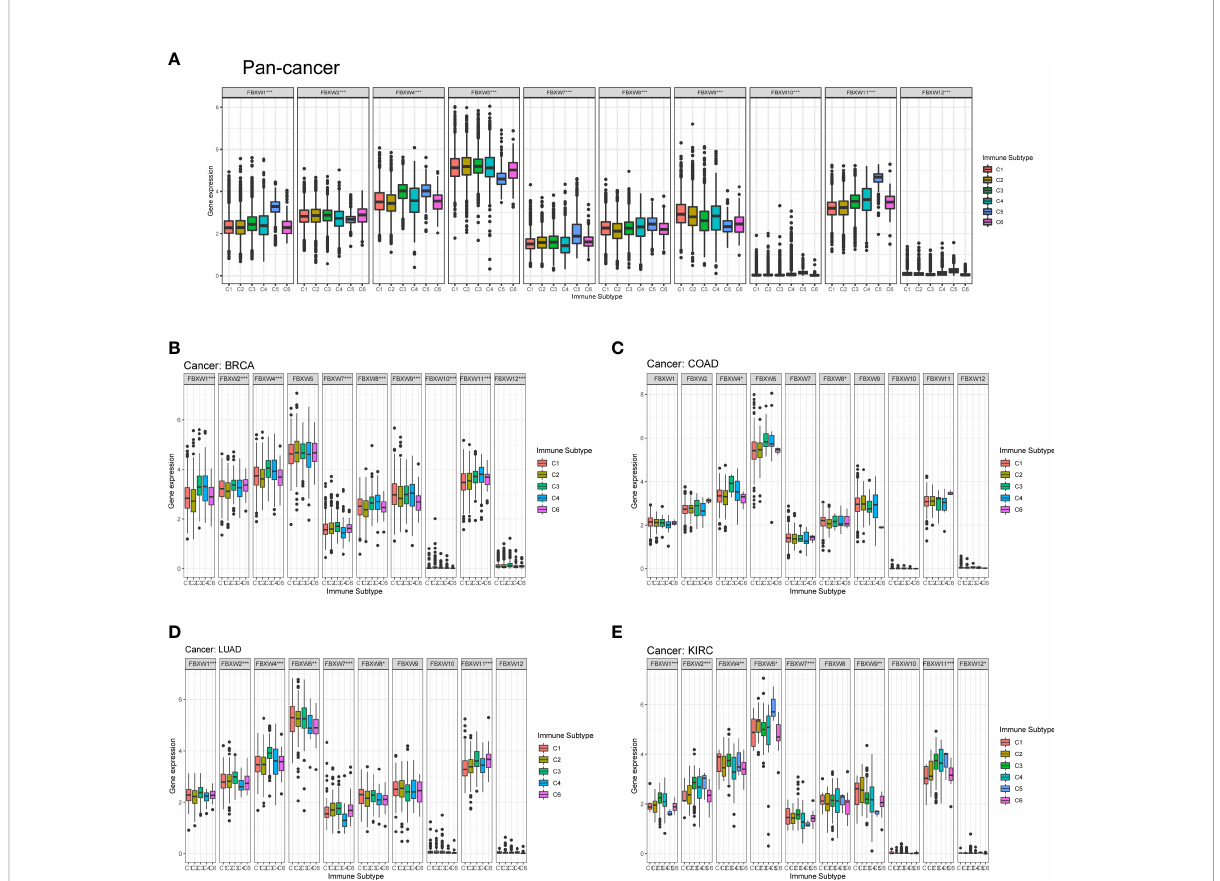
FIGURE 10 FBXW family gene expression level of different immune subtype in pan-cancer, and speci fi c four cancer types. (A) In pan-cancer. (B) In BRCA. (C) In COAD. (D) In LUAD. (E) In KIRC. X axis represents immune subtype, Y axis represents gene expression. * P< 0.05; ** P< 0.01; *** P< 0.001. C1: wound healing, C2: IFN-gamma dominant, C3: in fl ammatory, C4: lymphocyte depleted, C5: immunological quiet, and C6: TGF-beta